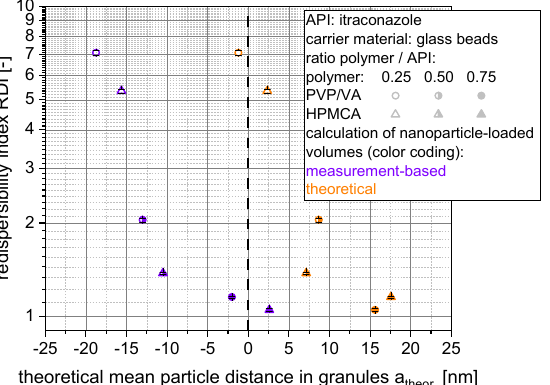
Figure 9. Correlation of the redispersibility index (RDI) with the mean theoretical nanoparticle distance for granules made out of insoluble glass beads as carrier material and an itraconazole nanosuspension stabilized with different amounts of PVP/VA or HPMC. Theoretical mean nanoparticle distances were calculated with theoretical and measurement-based nanoparticle-containing layer volumes.